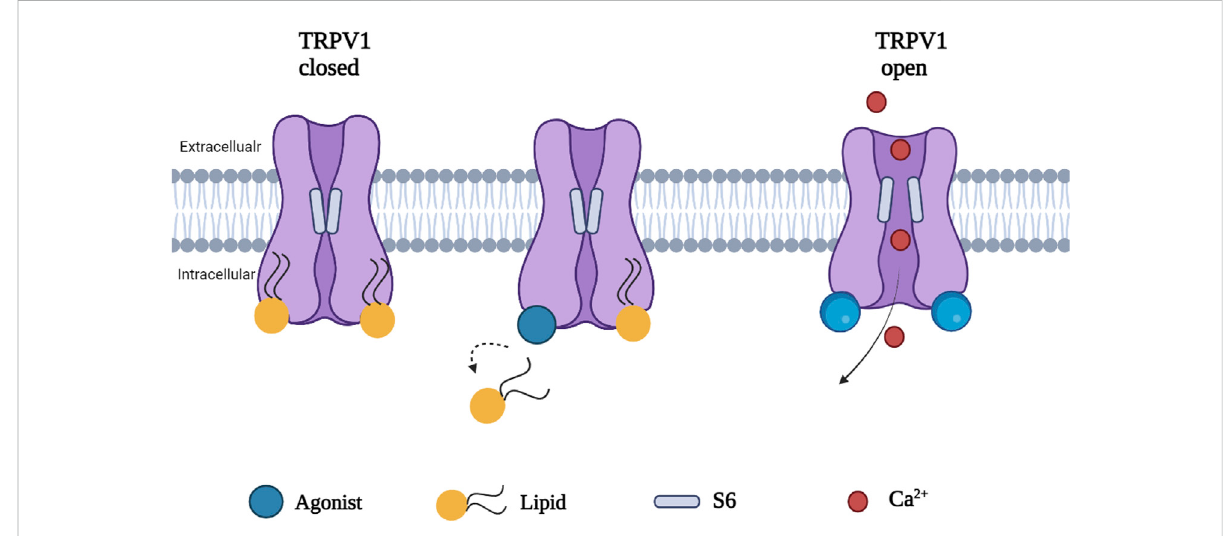
FIGURE 3 AproposedmechanismofTRPV1 activation.AgonistinducedconformationalchangeinTRPV1byfulldisplacementoftheregulatorylipidsinall subunits enhances suf fi cient S5 movement, allowing S6 movement and opening the